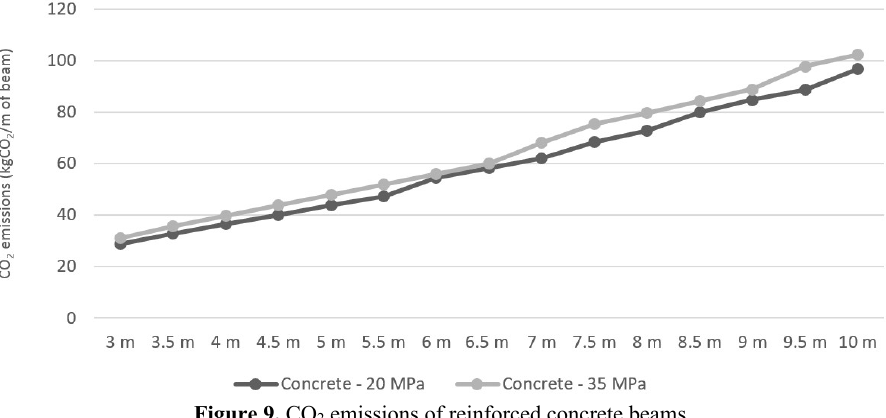
Figure 9. CO 2 emissions of reinforced concrete beams.